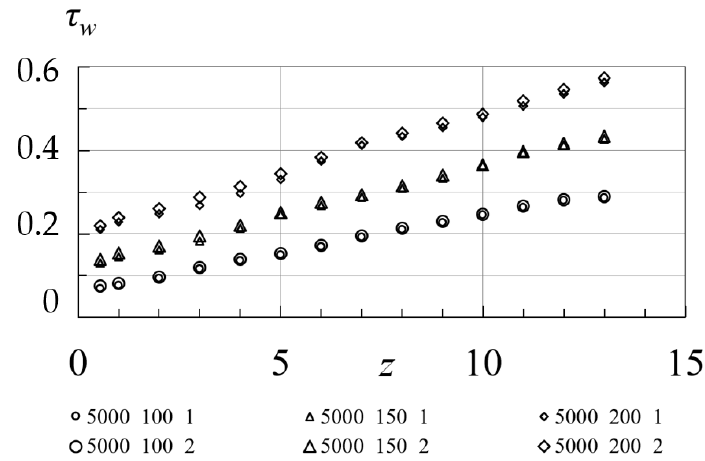
Figure 17. Distribution of tangential stresses τ w [Pa] on the duct walls along its length z [m] ( q 0 − Const ; G − Varia ).